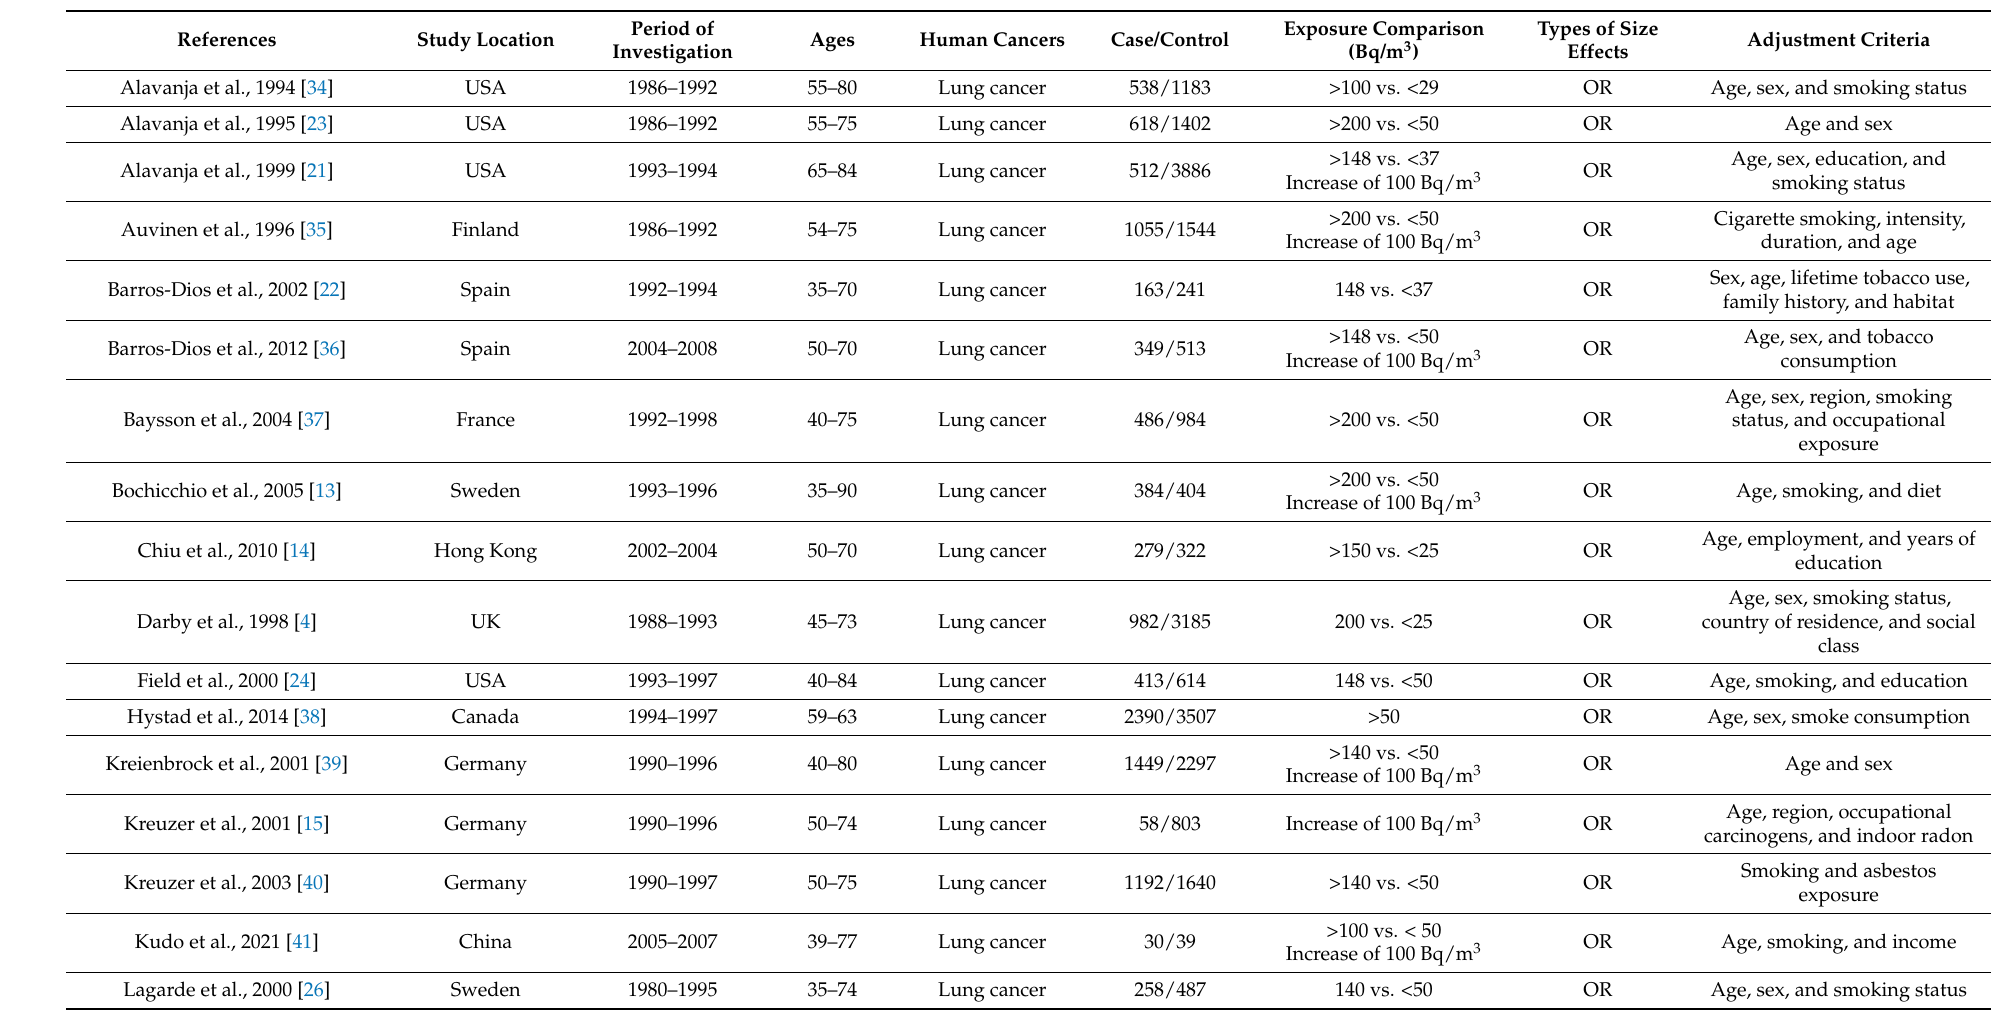
Table 1. Summary of the characteristics of case–control